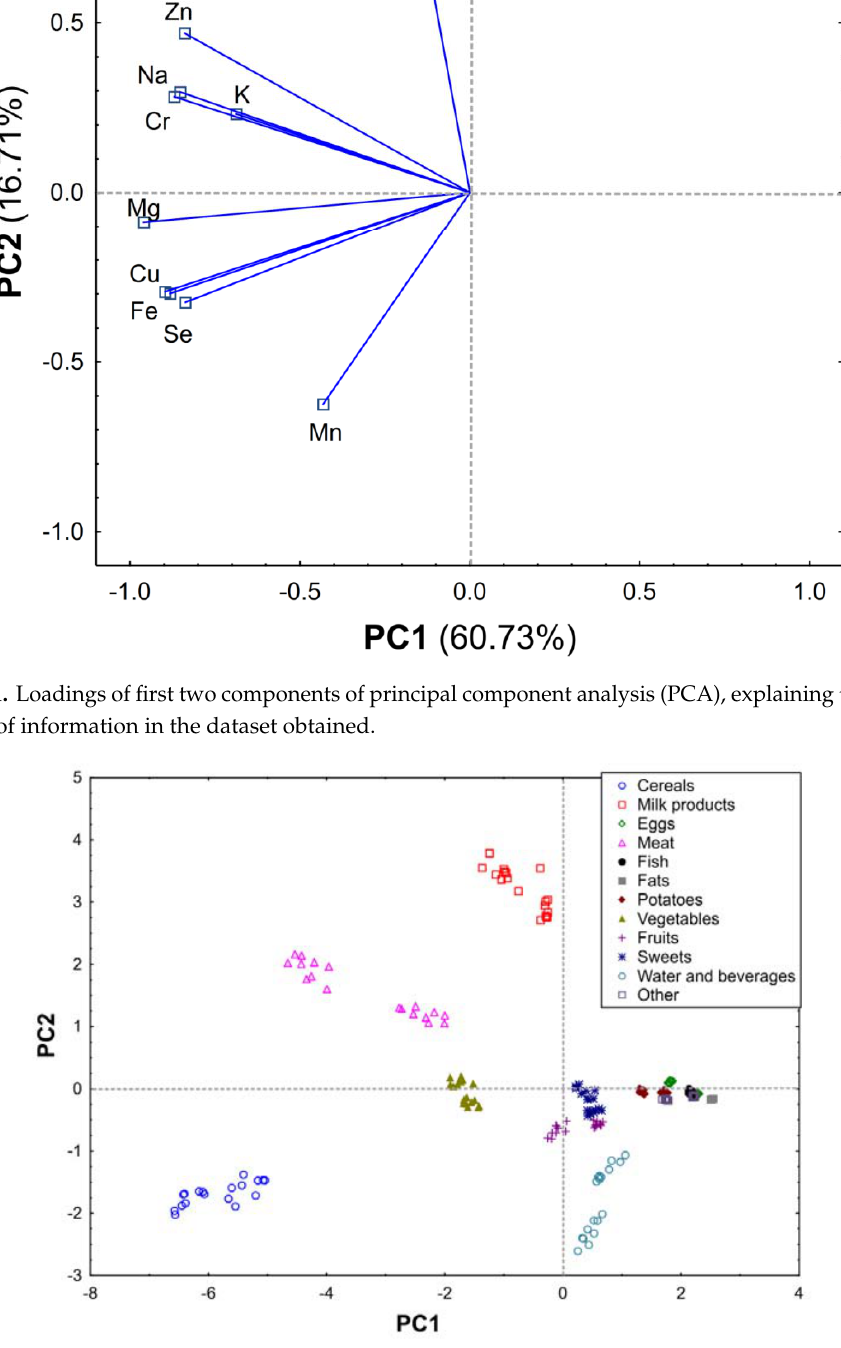
Figure 2. Scores of first two principal components of PCA, explaining together 77.44% of information in the obtained dataset.